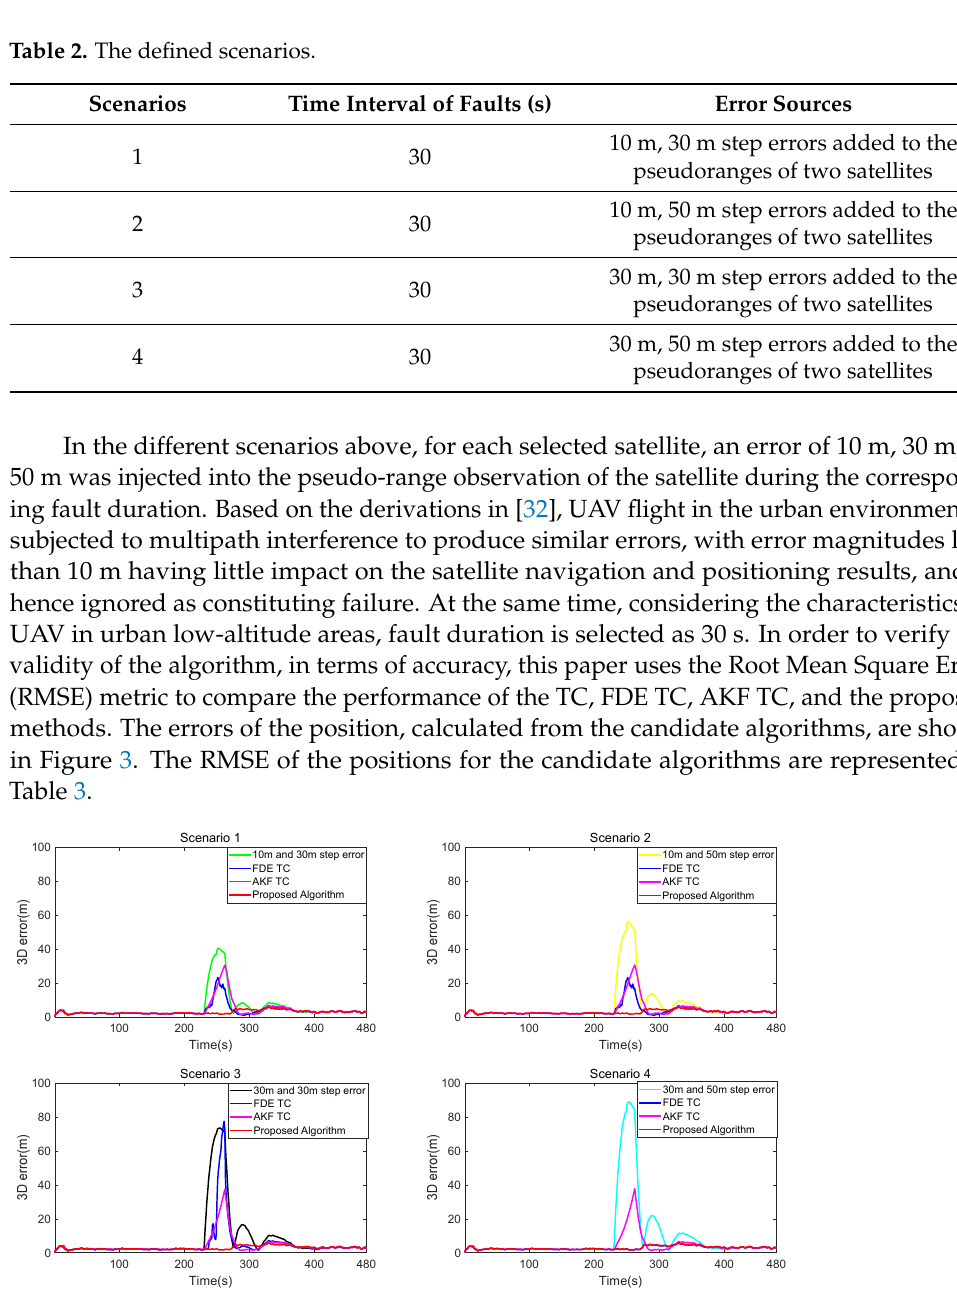
Figure 3. The positioning error of TC, FDE TC, AKF TC, and the proposed algorithm in the four fault scenarios. Table 3. Comparison of algorithm performance between TC, FDE TC, AKF TC, and the proposed algorithm in the different fault scenarios.